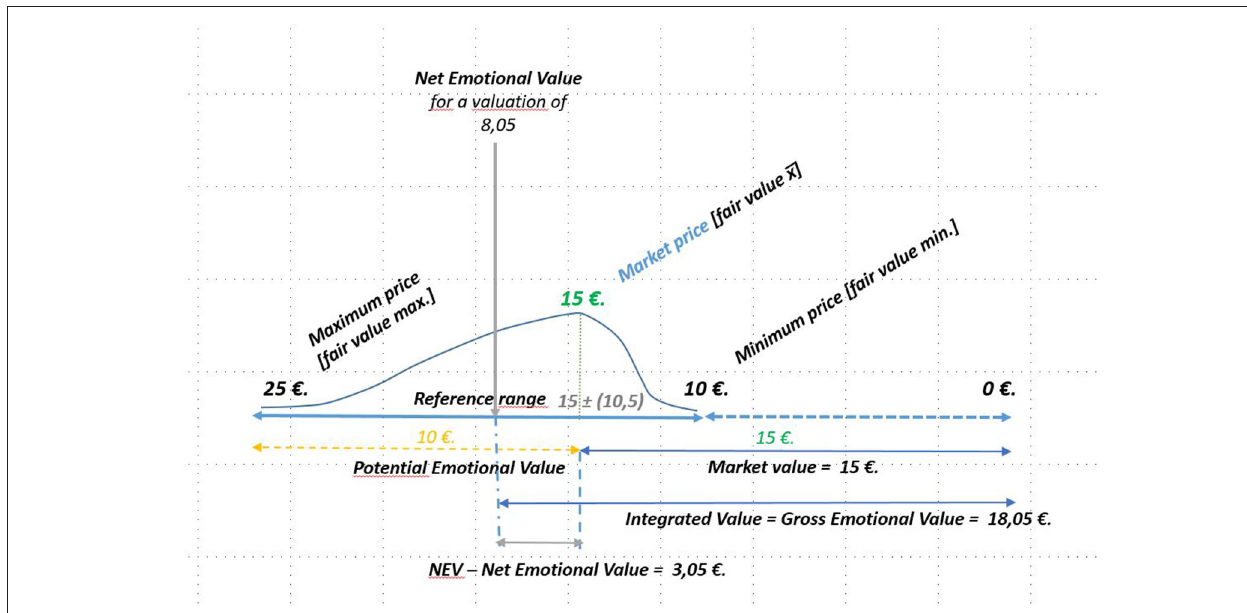
FIGURE 9 | Representation of the NEV. Source: own